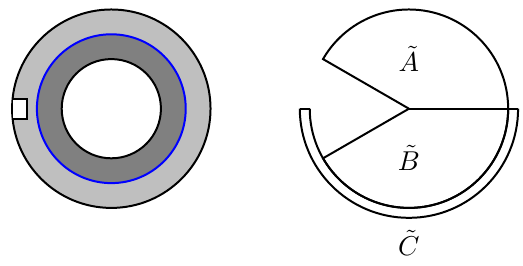
Figure 8 . (Color online.) Left: subregion C is the small white square in the constant time slice. Right: one copy of (cid:26) A . The picture shows the disk perpendicular to the horizon. The thin layer surrounding the lower half circle corresponds to ~ C